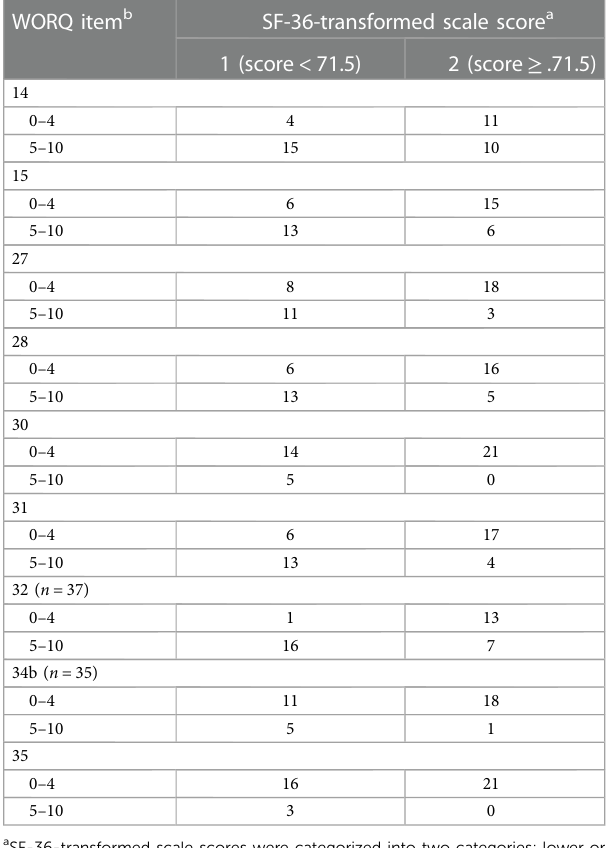
TABLE 2 Cross tabulations between WORQ and SF-36 items, n =40. TABLE 4 Spearman correlation analysis between physical capacity WORQ items and objective physical capacity measures, n